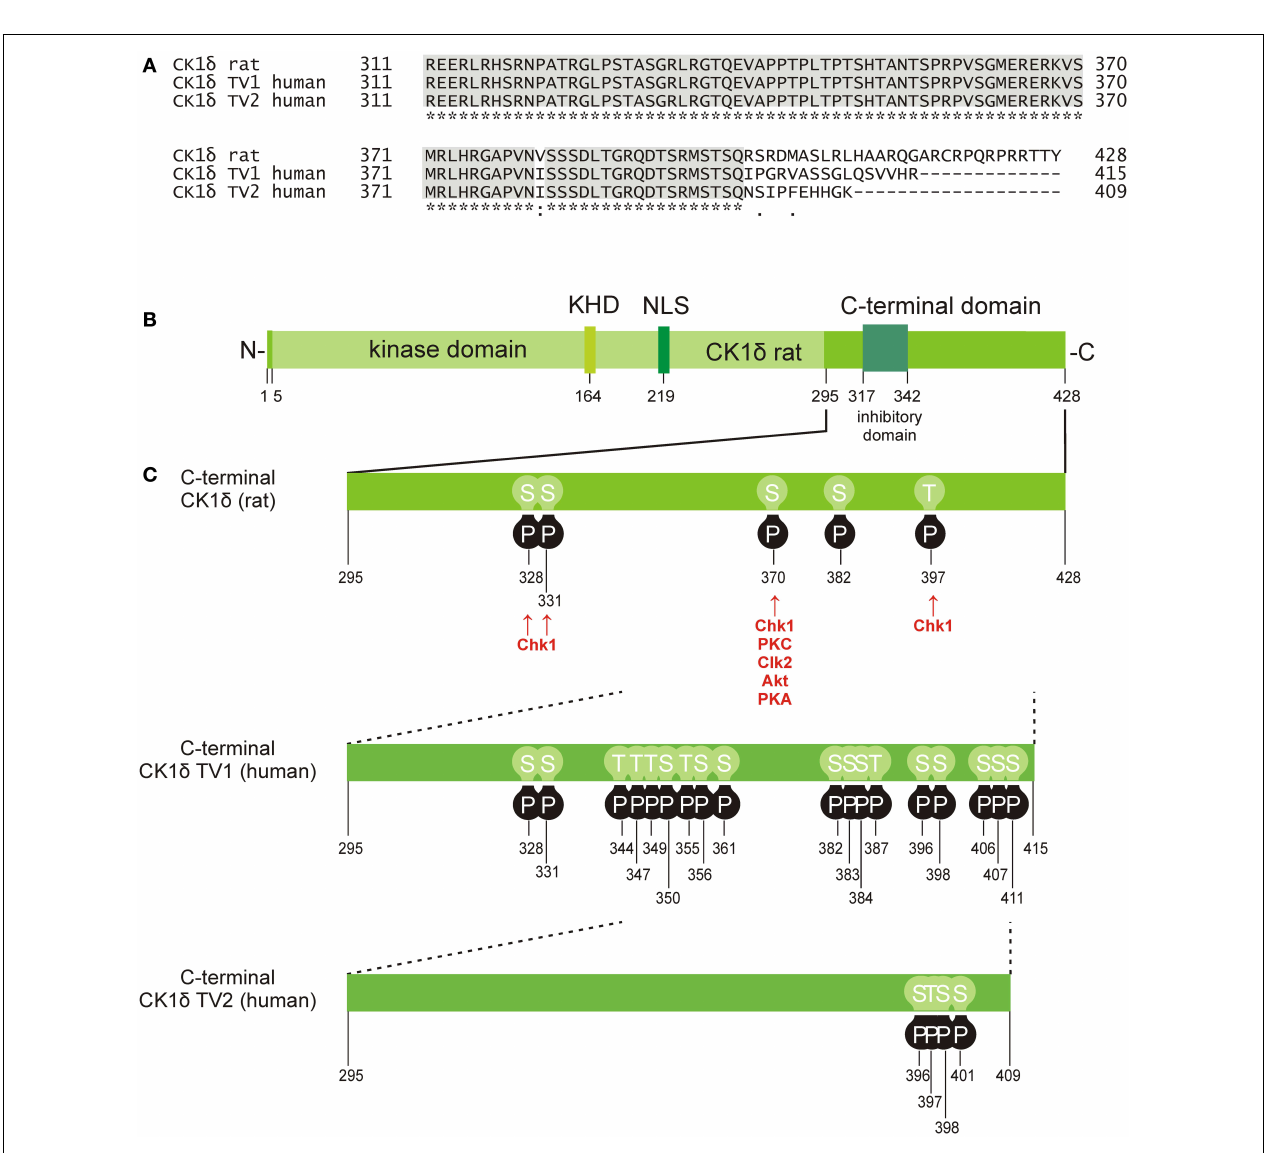
399. (B) Domain structure of rat CK1 δ (NLS: nuclear localization signal, KHD: kinesin homology domain). (C) Phosphorylation sites in the C-terminal regulatory domains of CK1 δ rat and human transcription variants 1 and 2, that have so far been confirmed experimentally (38–53). Kinases identified for phosphorylation of the C-terminal domain are shown for rat CK1 δ (38,